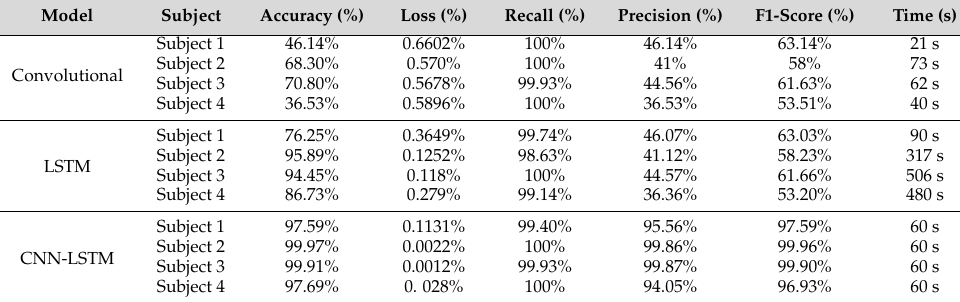
Table 10. Comparison with deep learning